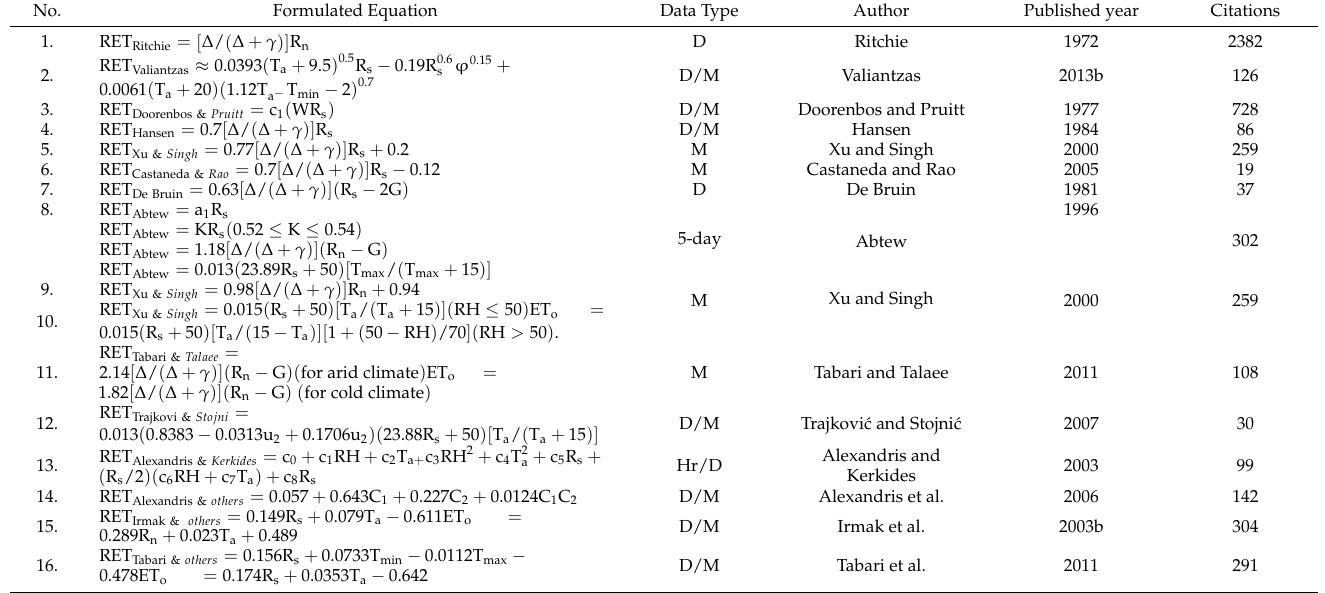
Table A5. RET radiation-based equations.